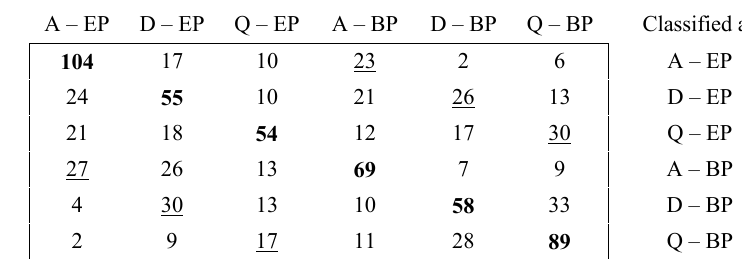
Table X: Confusion matrix for the classification considering interaction speech contexts and Portuguese